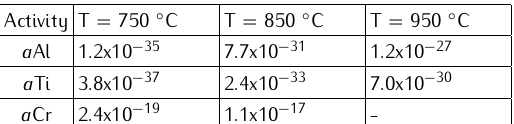
O , TiO 2 3 2 and Cr